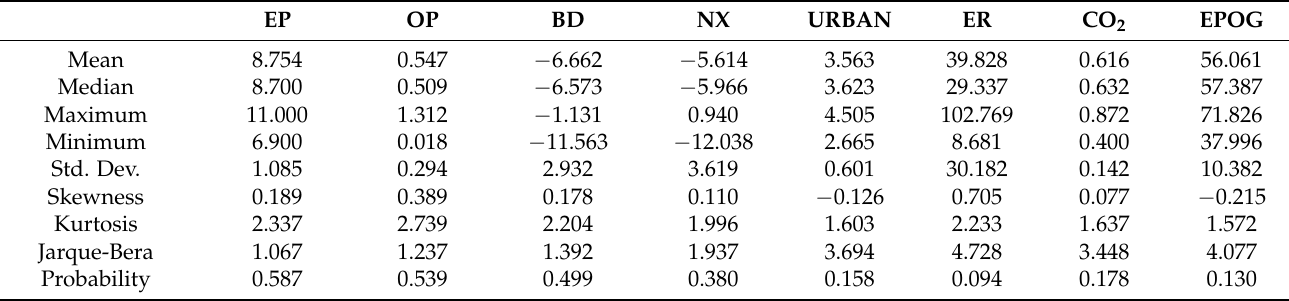
Table 2. Descriptive statistics of